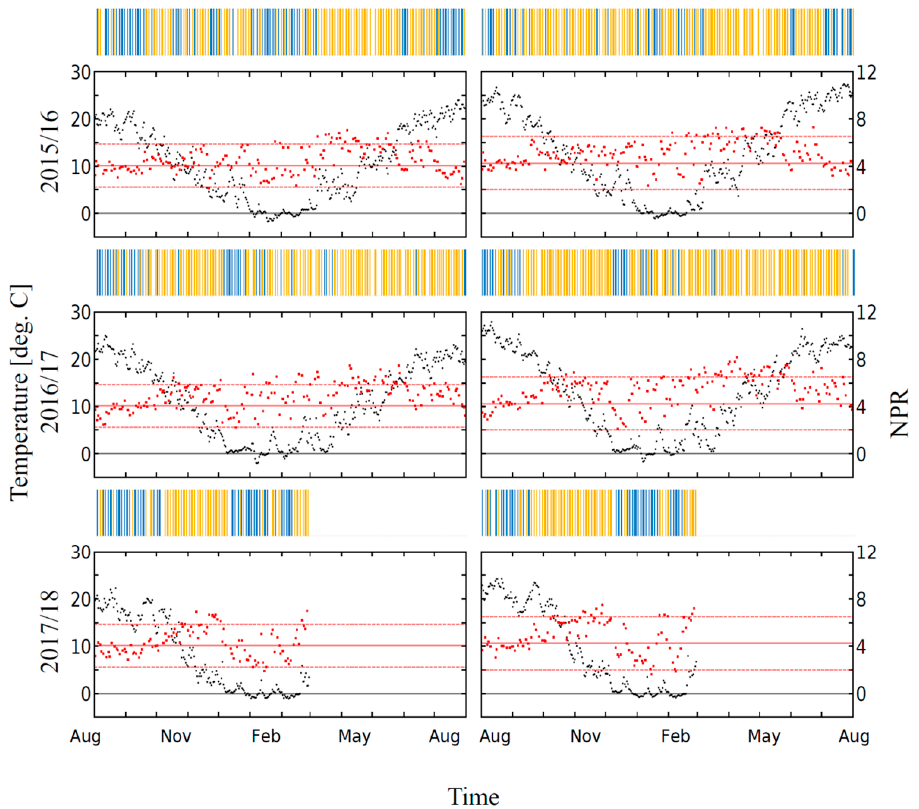
Figure 5. Same as Figure 4 but for Indiana (site 1606, grid 65806).